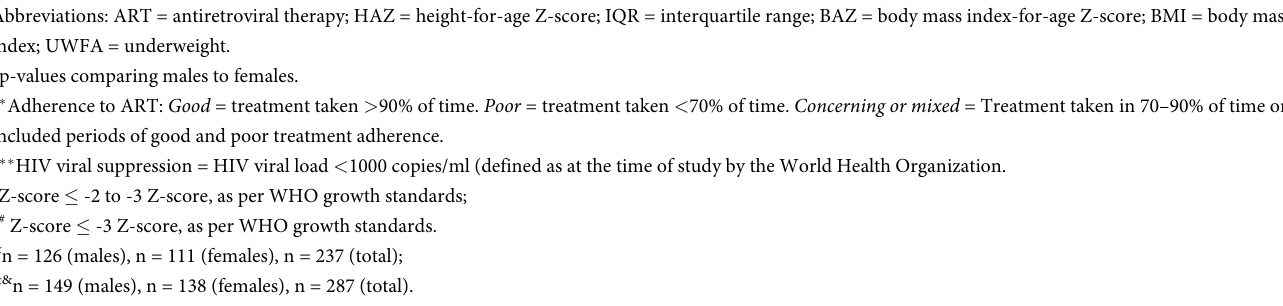
Abbreviations: ART = antiretroviral therapy; HAZ = height-for-age Z-score; IQR = interquartile range; BAZ = body mass index-for-age Z-score; BMI = body